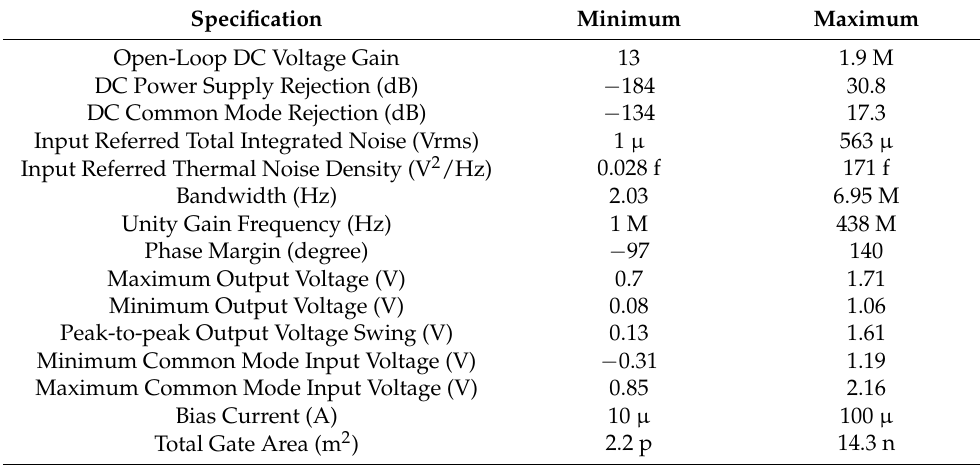
Table 2. Specifications used to predict the circuit topology alongside their ranges in the obtained dataset. Specification Minimum